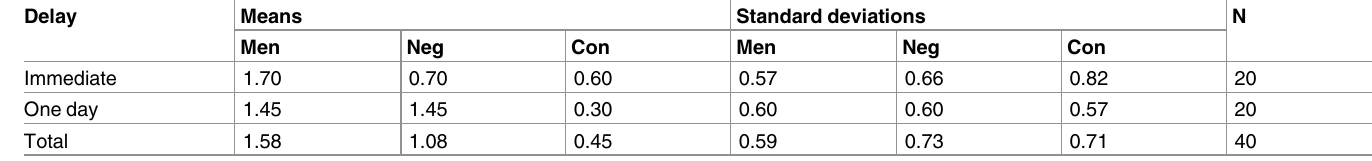
Table 2. Means and standard deviations for ‘Present’ answers across the experimental conditions—Experiment 2. Delay Means Standard